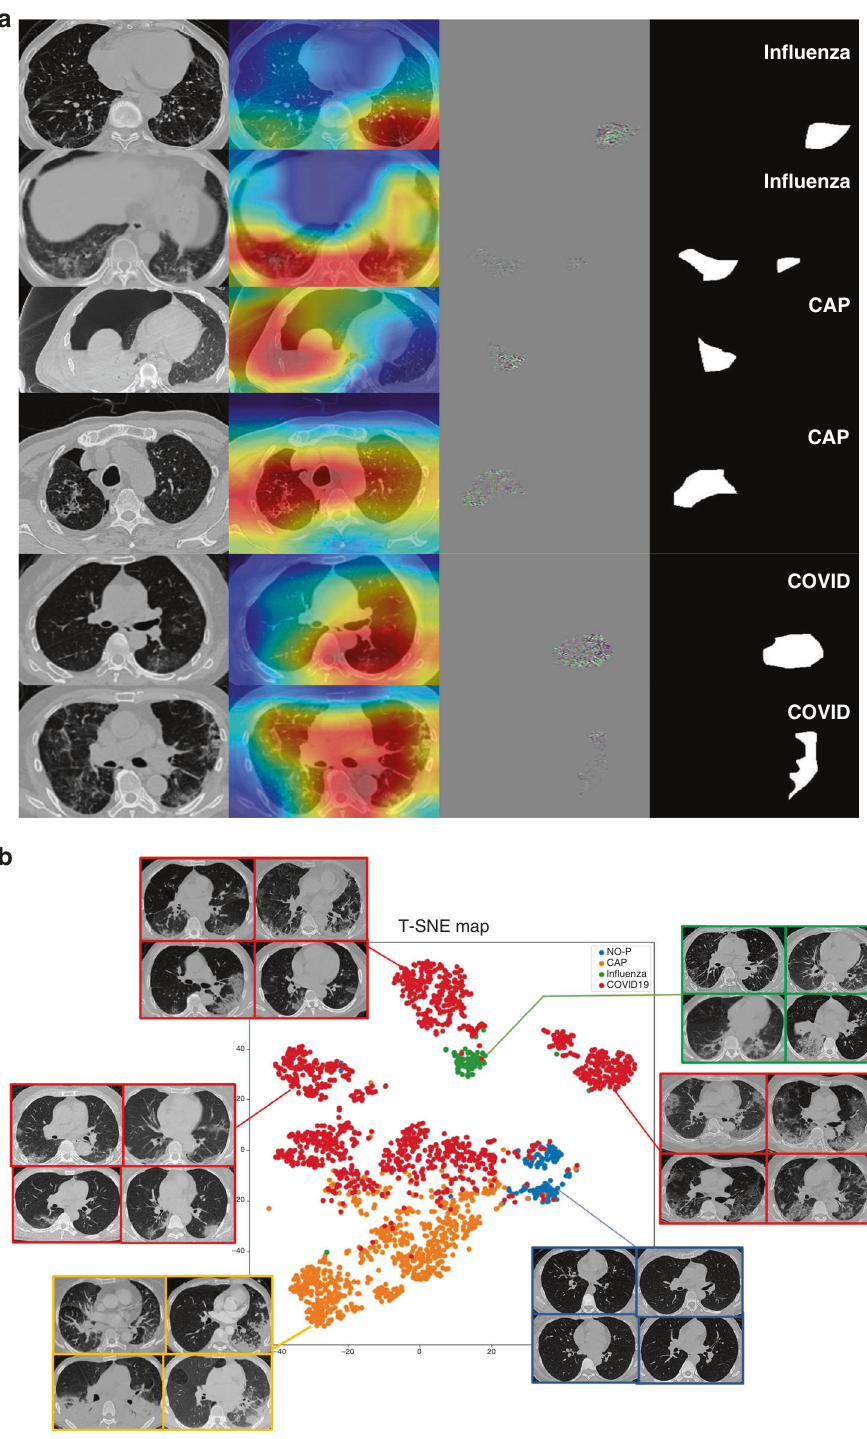
Fig. 7 Interpreting the AI system. a Visualizing feature maps via Grad-CAM. Notes: two slices of each of three representative subjects are used for the visualization of AI diagnosis. From left to right: original CT image; coarse-resolution attentional regions overlaid on CT image; high-resolution attentional regions with fi ne granularity; and binarized maps of region of attention obtained from Guided Grad-CAM. b Visualizing features via t